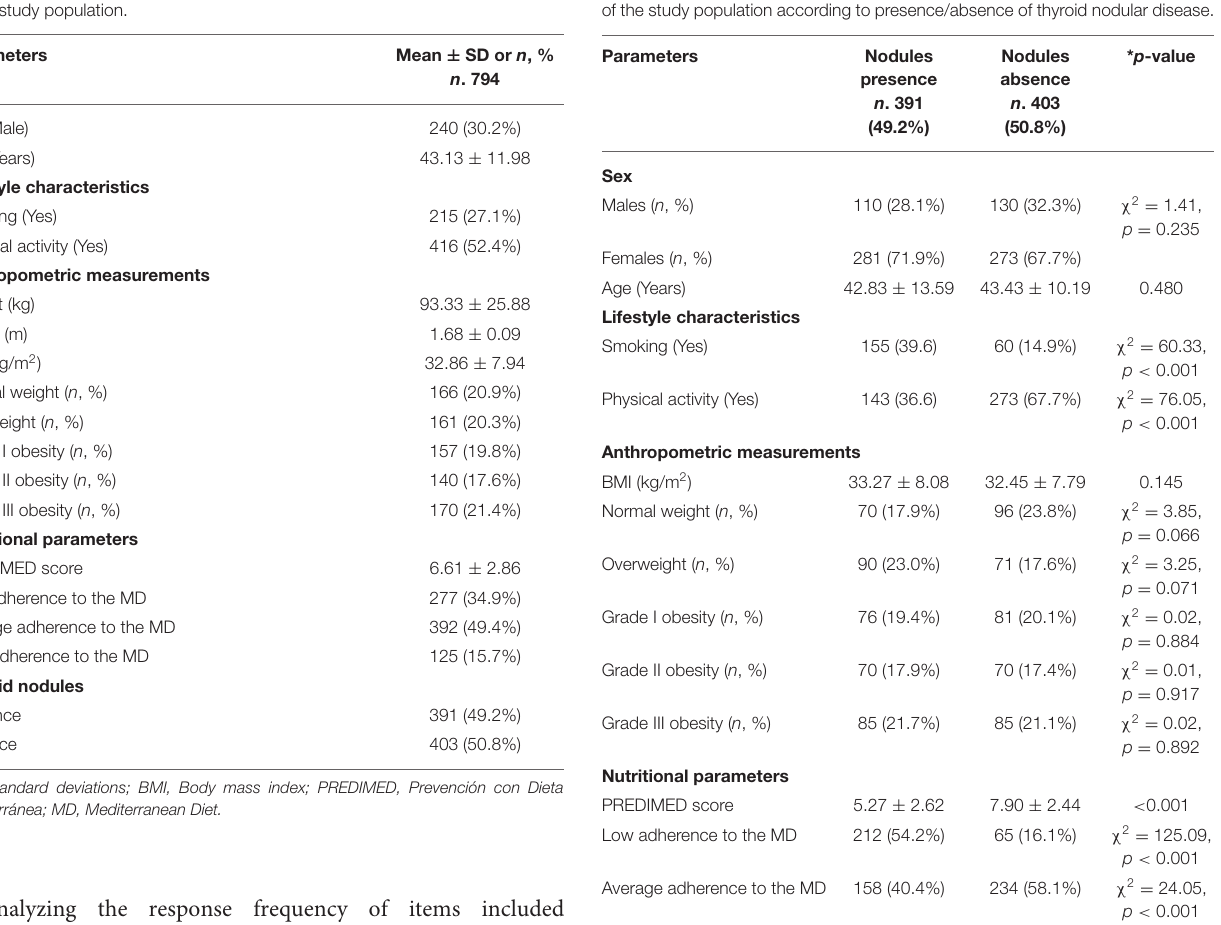
TABLE 2 | The descriptive characteristics, including gender, age, lifestyle characteristics, anthropometric measurements, nutritional, and thyroid parameters of the study population according to presence/absence of thyroid nodular